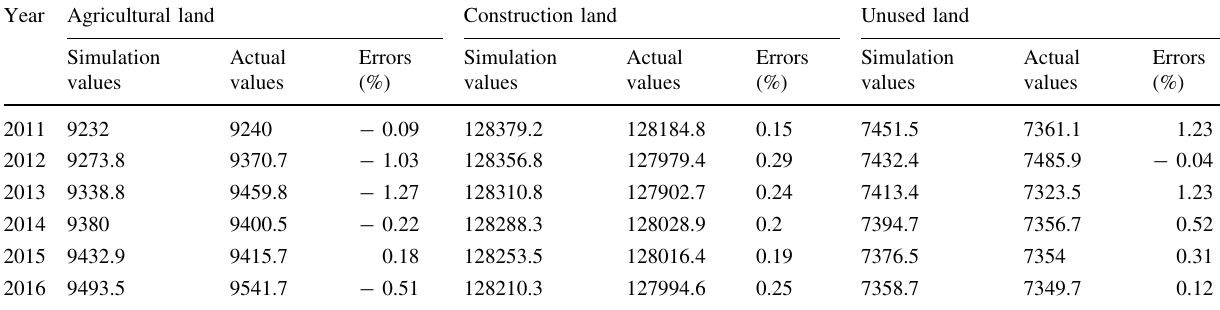
Fig. 3 Flow diagram of system dynamic model of land use system in Mentougou District Table 1 Simulation errors of test stage (unit: hm 2 ) Year Agricultural